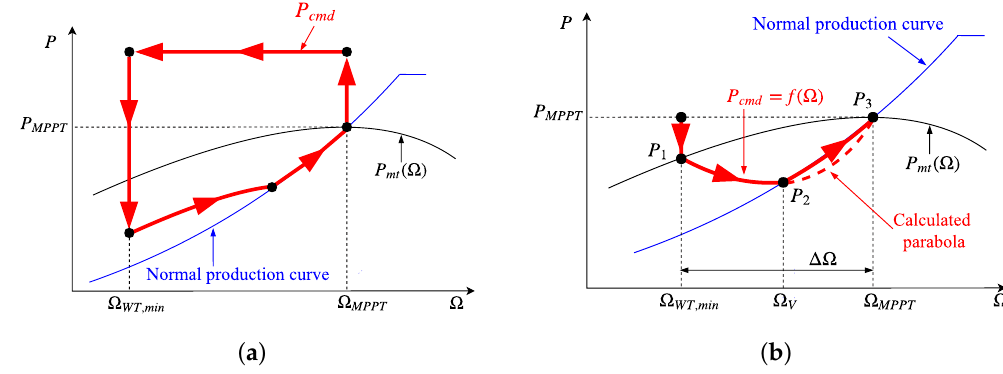
Figure 8. Comparison of frequency control strategies for VSWT. ( a ) Control strategy in [23]; ( b ) Adaptive and smooth proposed control strategy. Energies 2018 , xx